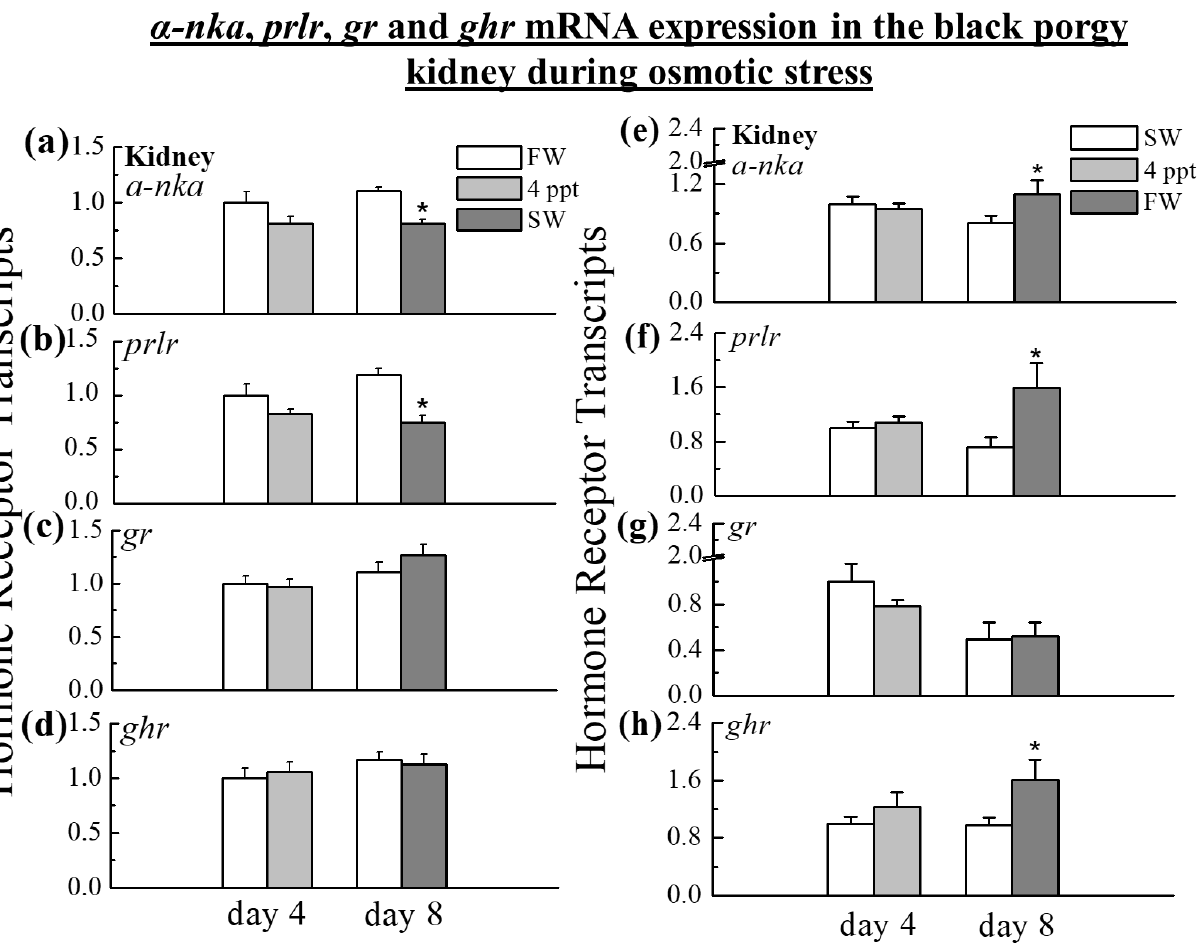
Figure 5. Q-PCR was performed to analyze the transcripts of α -nka , prlr , gr , and ghr in the kidney during the transfer of black porgy from FW to 4 ppt and SW ( a – d ), and from SW to 4 ppt and FW ( e – h ) on day 4 and day 8. The relative gene expression was normalized to the control value on day 4. The results (n = 9) are expressed as the mean ± SEM. Asterisks (*) indicate significant differences ( p < 0.05) between the control and treated group.